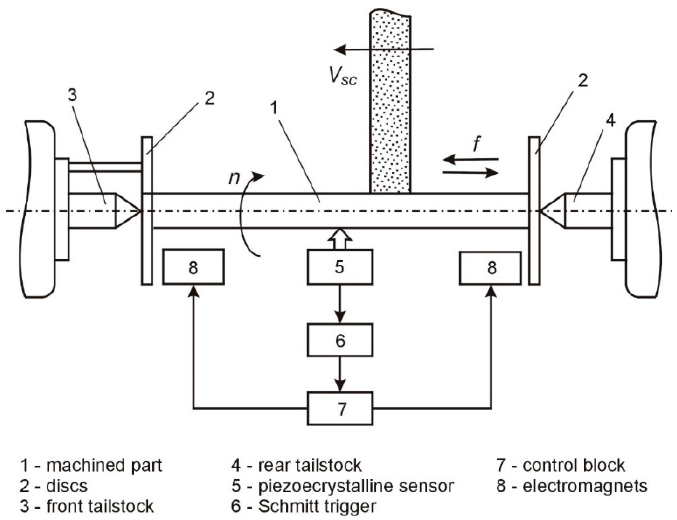
Figure 6. Block diagram of the measurement and compensation system of bending vibrations during grinding [10].